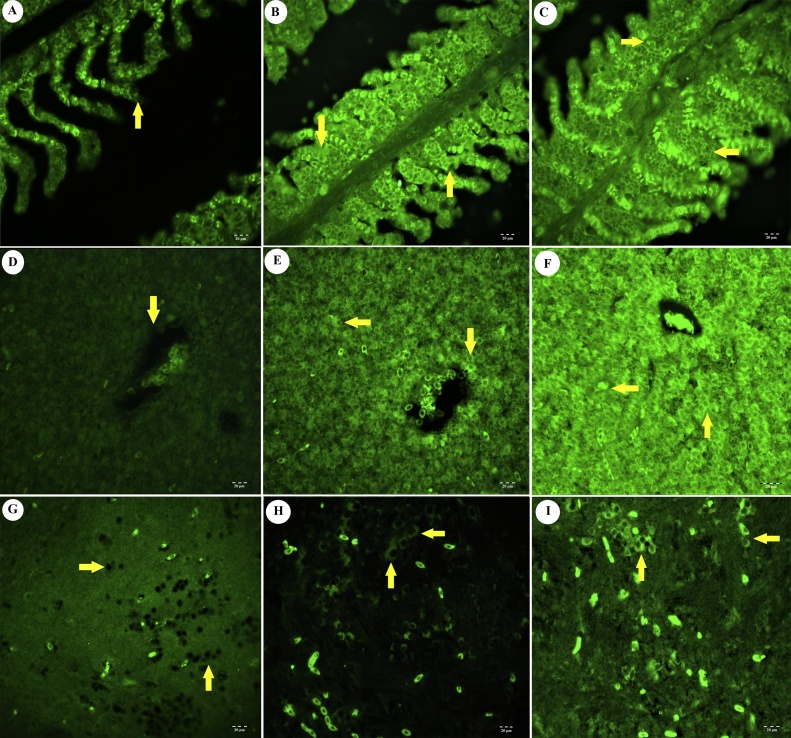
Immunoflorescence staining results of 8-OHdG (96 h). A) Lamella of gill tissue, (arrow). Control group. IF. 20 μm. B) Positivity in lamellar cells of gill tissue (arrows). Low dose toxic group. IF. 20 μm. C) Positivity in lamellar cells of gill tissue (arrows). High dose toxic group. IF. 20 μm. D) Liver tissue, vena centralis (arrow). Control group. IF. 20 μm. E) Positive reactions in hepatocytes (arrows). Low dose toxic group. IF. 20 μm. F) Positive reactions in hepatocytes (arrows). High dose toxic group. IF. 20 μm. G) Neurons (arrows). Control group. IF. 20 μm. H) Positivity in neurons (arrows). Low dose toxic group. IF. 20 μm. I) Positivity in neurons (arrows). High dose toxic group. IF. 20 μm.